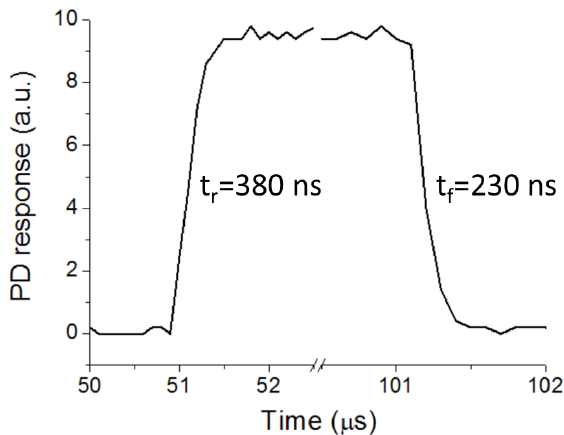
Figure 7. Time response of the PD in the optical interconnection of Figure 3 for 10 kHz TTL modulated LED. The 10%−90% rise time (t r ) and fall time (t f ) are 380 ns and 230 ns, respectively. LED. The 10% − 90% rise time (t r ) and fall time (t f ) are 380 ns and 230 ns,